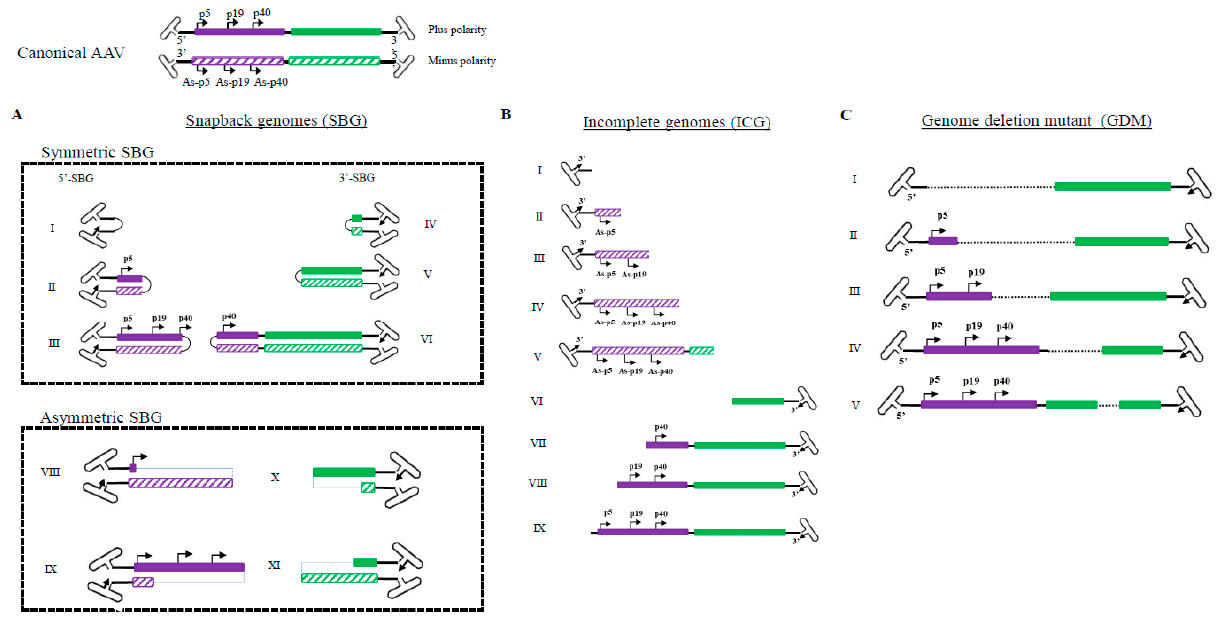
Figure 1. Illustration of molecular configurations for major categories of subgenomic particles in a wild type AAV population. (Summarized from 409919 sequencing reads of two PacBio sequencing runs: 220645 and 189274) Both plus and minus strands of the canonical AAV genome are shown at the top. ( A ). Varying lengths of snapback AAV genomes (SBG) are illustrated, including both symmetrical snapback genomes (sSBG) and asymmetrical snapback genomes (aSBG). ( B ). Incomplete genomes (ICG) in the AAV population are missing the 5 ′ terminal sequences. ( C ). Genome deletion mutants (GDM) have both 5 ′ and 3 ′ ITR and miss in the mid- region of AAV. Only plus strand particles are plotted.